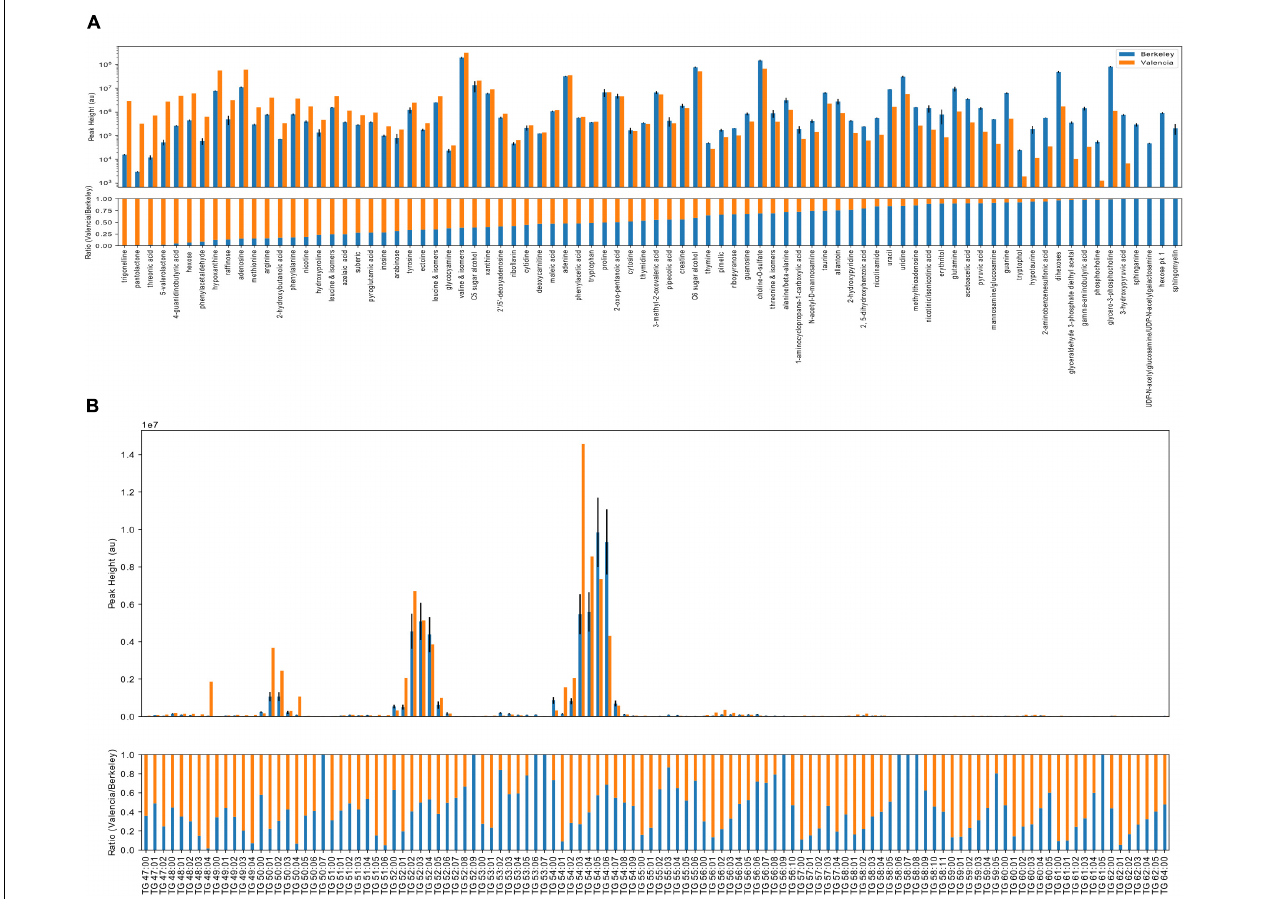
FIGURE 6 | Metabolomics analyses of the Californian and Valencian solar panel samples. Ion abundance results for polar metabolites (A) and triacylglycerol lipids (B) . Absolute ion abundances (upper panels, log scale) and relative ion abundances (lower panels, scaled to 1) corresponding to the identified metabolites are indicated in orange (Valencia, Spain) and blue (Berkeley, CA, United States). Without quantification, ion abundances cannot be used to compare between metabolites due to differences in ionization efficiencies. Here, ion abundances of identified metabolites may be used to compare relative abundances between Berkeley and Valencia. Polar metabolites (A) are ranked by relative abundance and triacylglycerol lipids are sorted by chain length followed by degree of